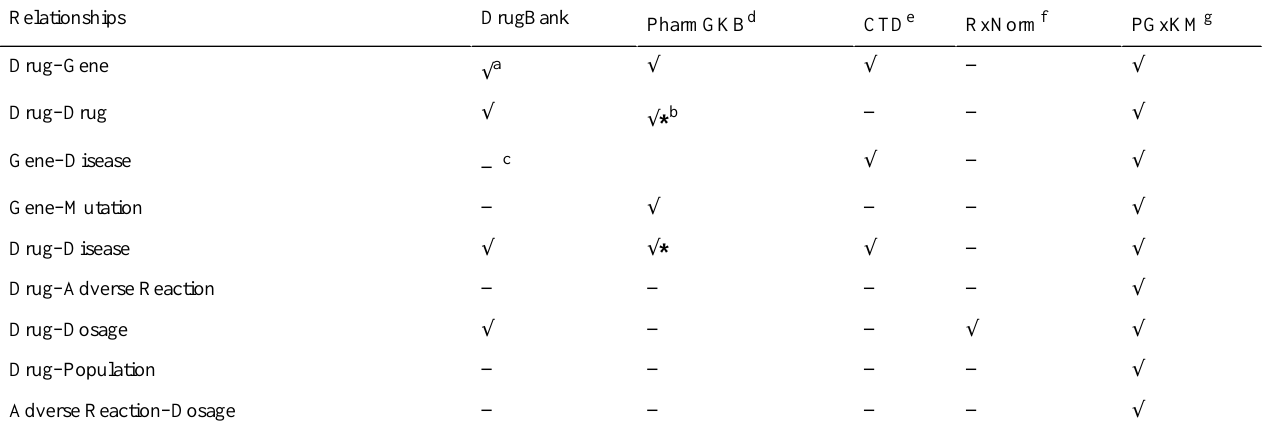
Table 6. Comparison between pharmacogenomics data